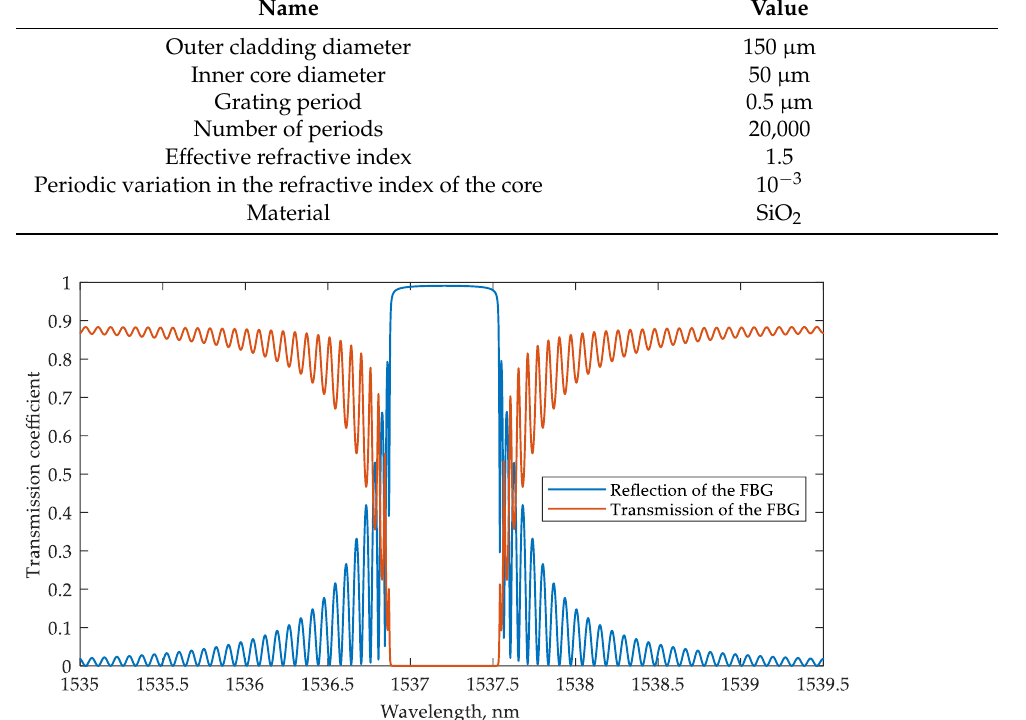
Figure 13. FBG transmission and reflection spectra at the resonant wavelength λ B = 1537.2 nm.